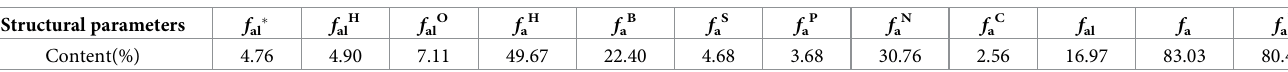
anthracite was calculated to be 40. According to the results of elemental analysis of the coal samples, the carbon content of anthracite was 85.53%, the oxygen content was 6.53%, the Table 4. Structural parameters of the coal sample molecular structure